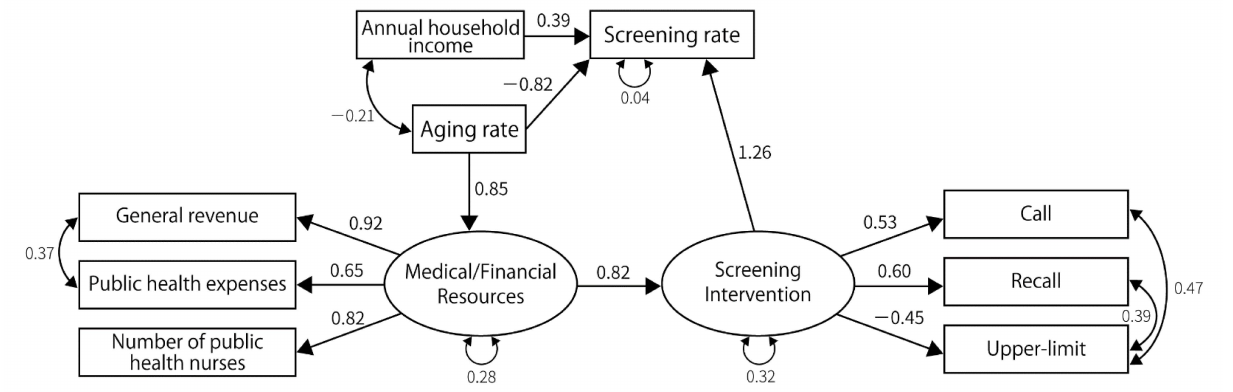
Figure 4. The final model for breast cancer. GFI = 0.930, AGFI = 0.850, PGFI = 0.434, SRMR = 0.080, CFI = 0.954, RMSEA = 0.096, p -value by χ 2 test = 0.091, χ 2 = 30.03, degrees of freedom =